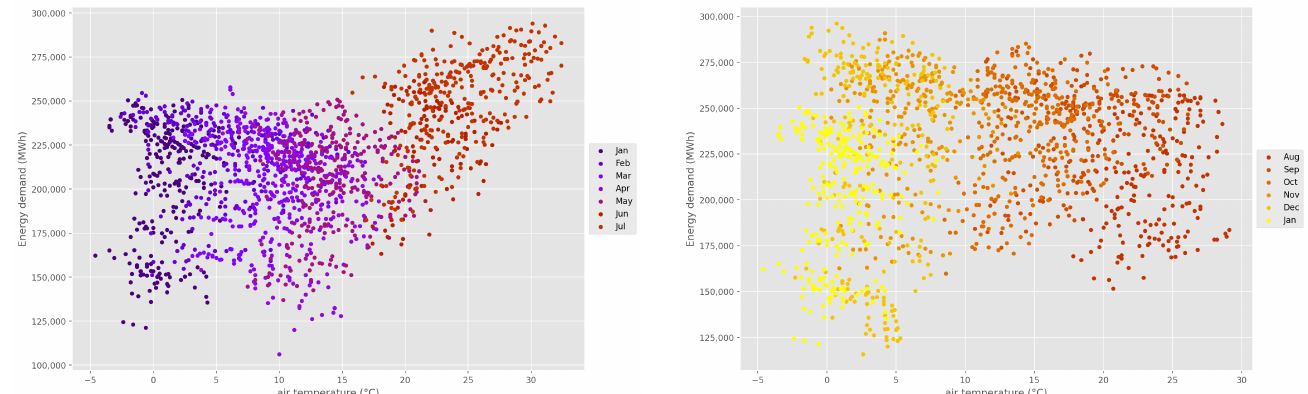
Figure 6. Hourly load vs. hourly air temperature in a representative city in Northern